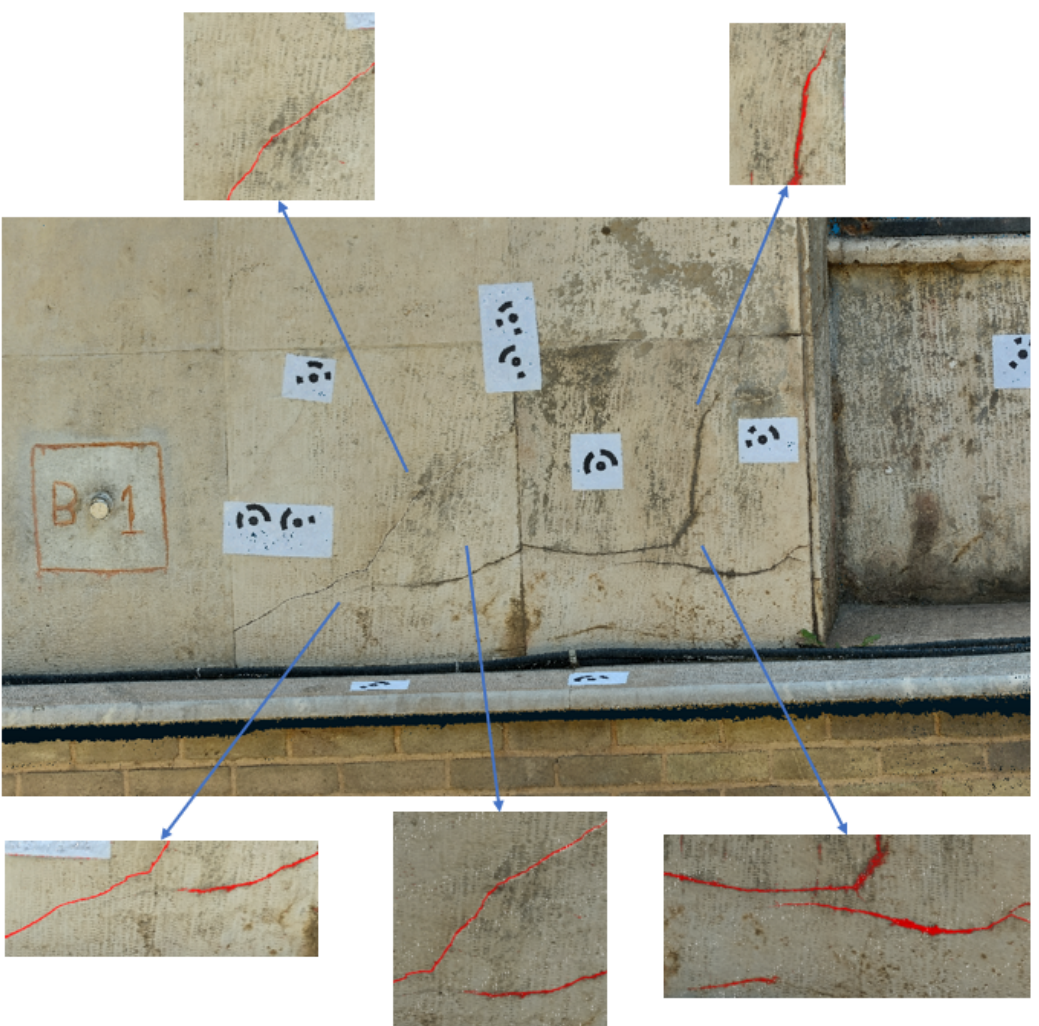
Figure 7. Segmented crack points in the point cloud.